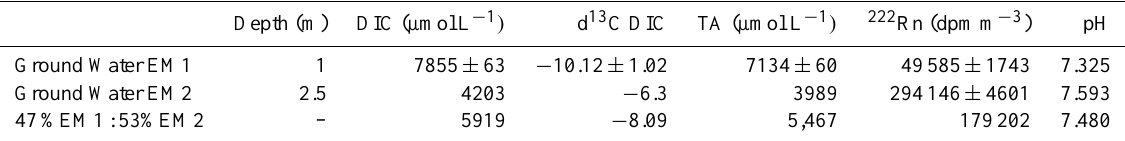
Table 1. Measurements of solutes in the groundwater endmembers (EM), EM1 n = 3, EM2 n = 1. δ 13 C DIC of the mixed endmember was estimated from the y-intercept of a Keeling plot. The 47%EM1:53%EM2 is the concentration calculated from the δ 13 C DIC-estimated endmember